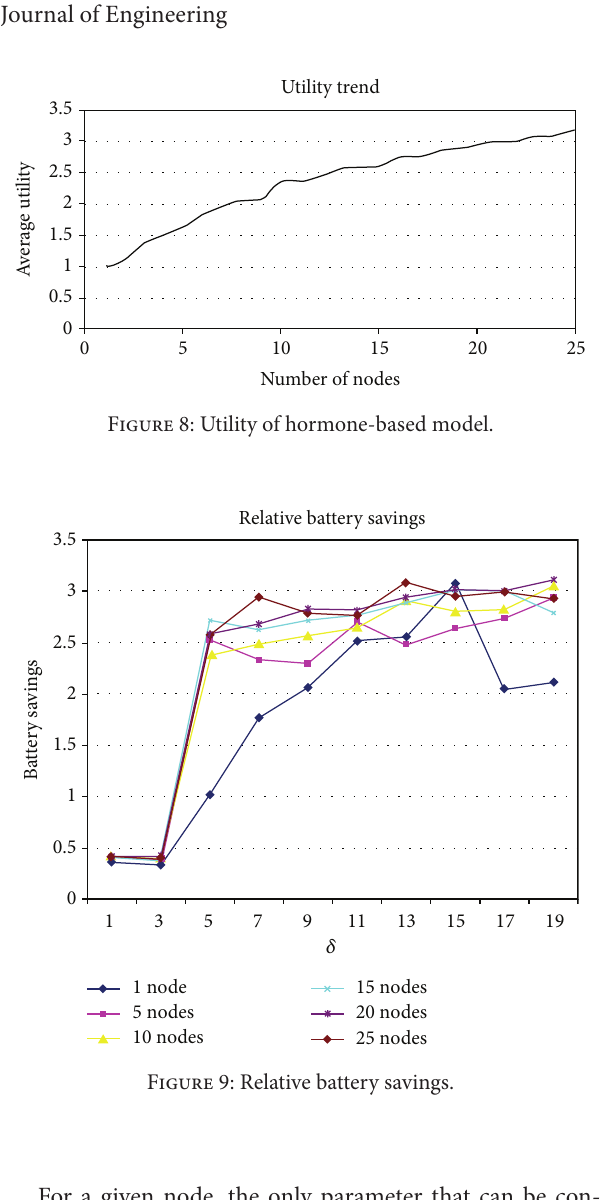
Figure 11: From a toy car to a mobility